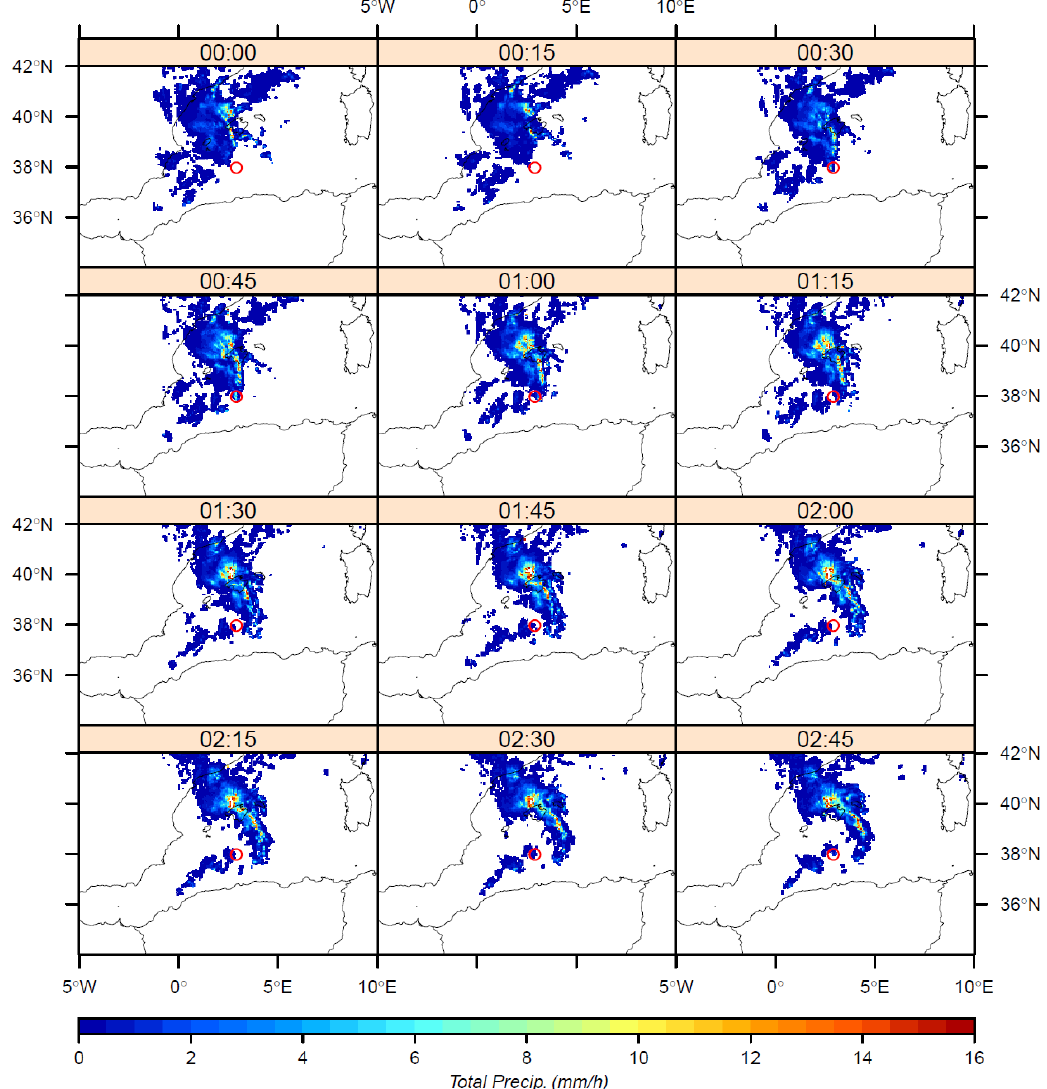
Figure 4. Rain rates (mmh − 1 ) during the night between the 4 and 5 June when Rain FAST was collected on board. Issued from European rain radar composites (OPERA programme) of 5 June between 00:00 and